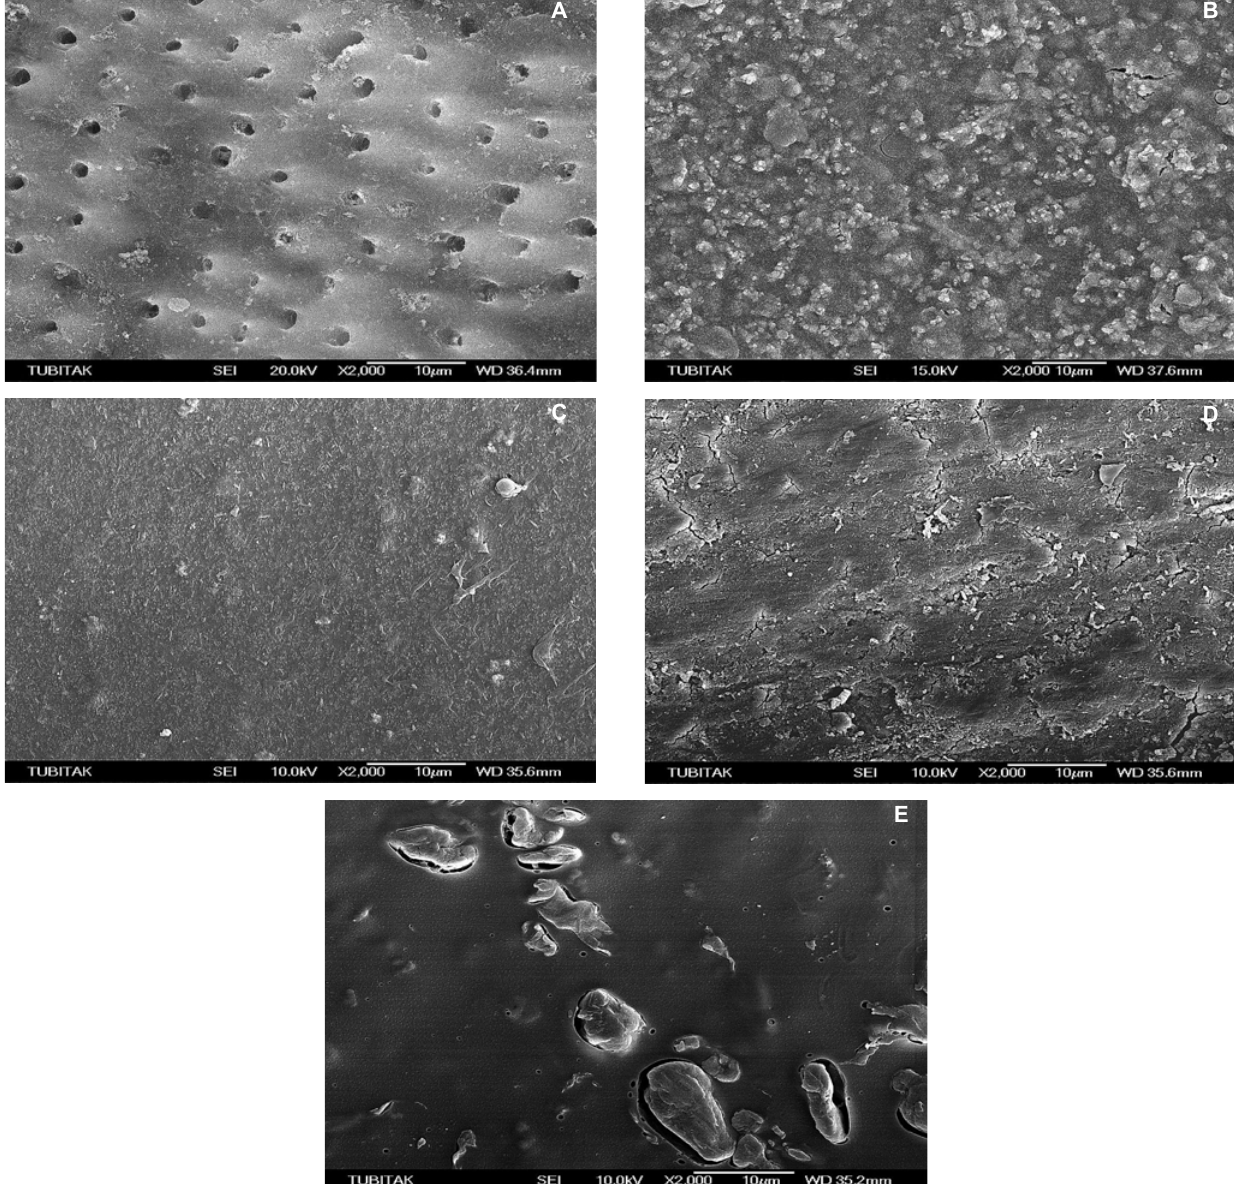
FIGURE 2- SEM micrographs of dentin surfaces of specimens treated with the desensitizing agents. A, control (no treatment); B, treated with 2.71% NaF and 2.92% CaF-containing desensitizing agent (Bifluorid 12); C, treated with 2.26 % NaF-containing desensitizing agent (Fluoridin); D, treated with 0.5% NaF and 35% HEMA-containing desensitizin agent (PrepEze); E, treated with 1% NaF and 1% CaF-containing desensitizing agent (Thermoline). Original magnification